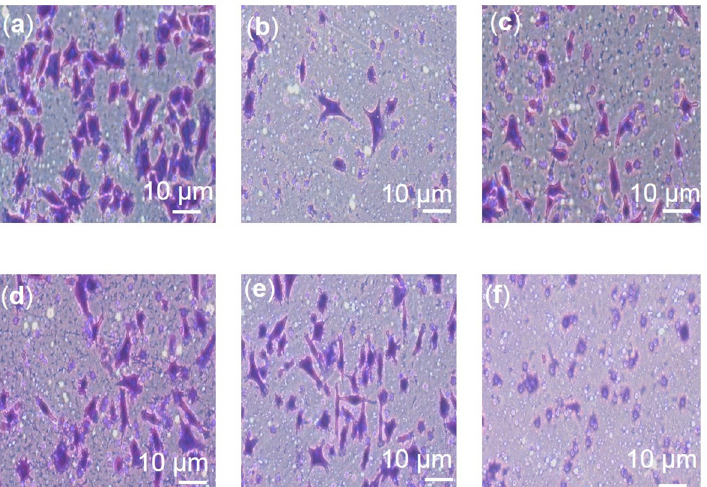
Figure 8. ( a ) Untreated; ( b ) F3 (100 µ g/mL); ( c ) Lutein (20 µ M); ( d ) β -sitosterol (25 µ M); ( e ) Stigmas- terol (90 µ M); ( f ) Tamoxifen (20 µ M). Determination of cancer cell migration by transwell migration assay observed under a microscope at 200 × magnification.